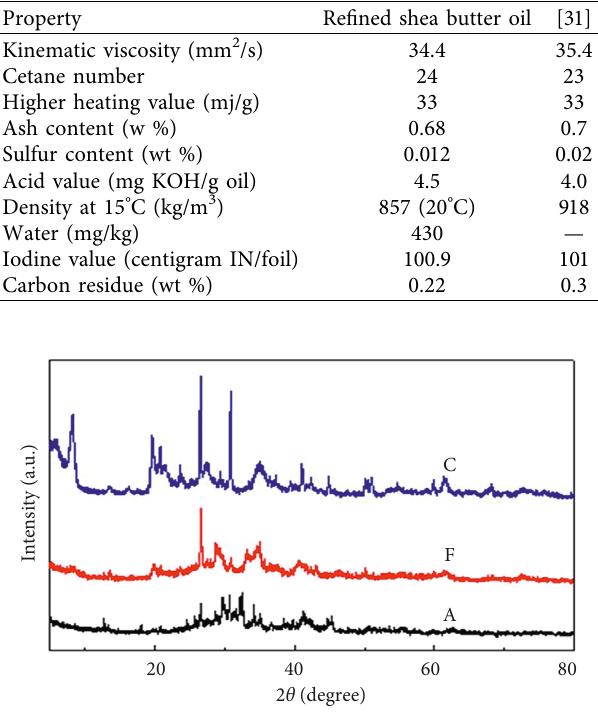
Figure 1: (A) XRD pattern of ZnO doped on activated clay (ZD). (C) XRD pattern of activated dolomite (AC). (F) XRD pattern of SnO 2 doped on activated clay